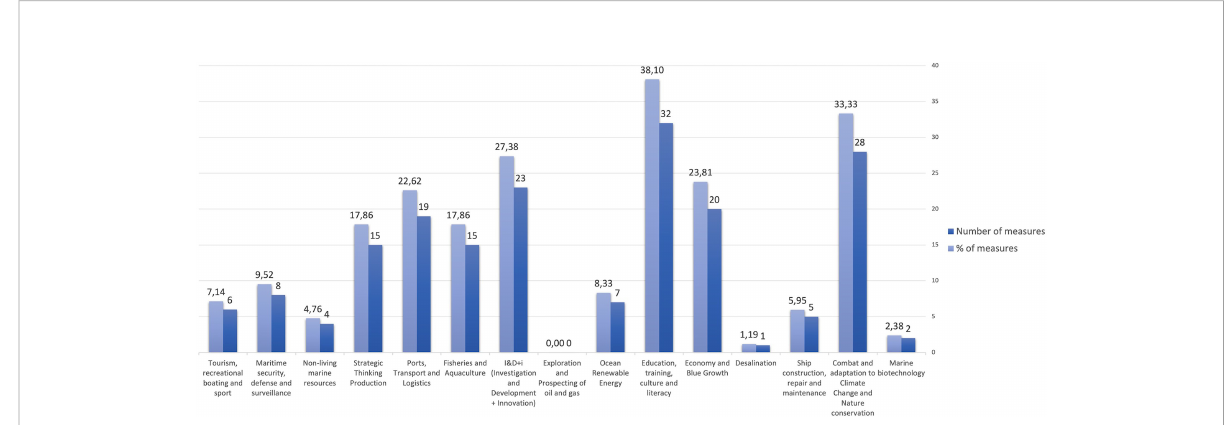
FIGURE 8 Number of identi fi ed measures, and corresponding percentage, by socio-economic sector, of Portugal ’ s National Ocean Strategy. Source: Created by the